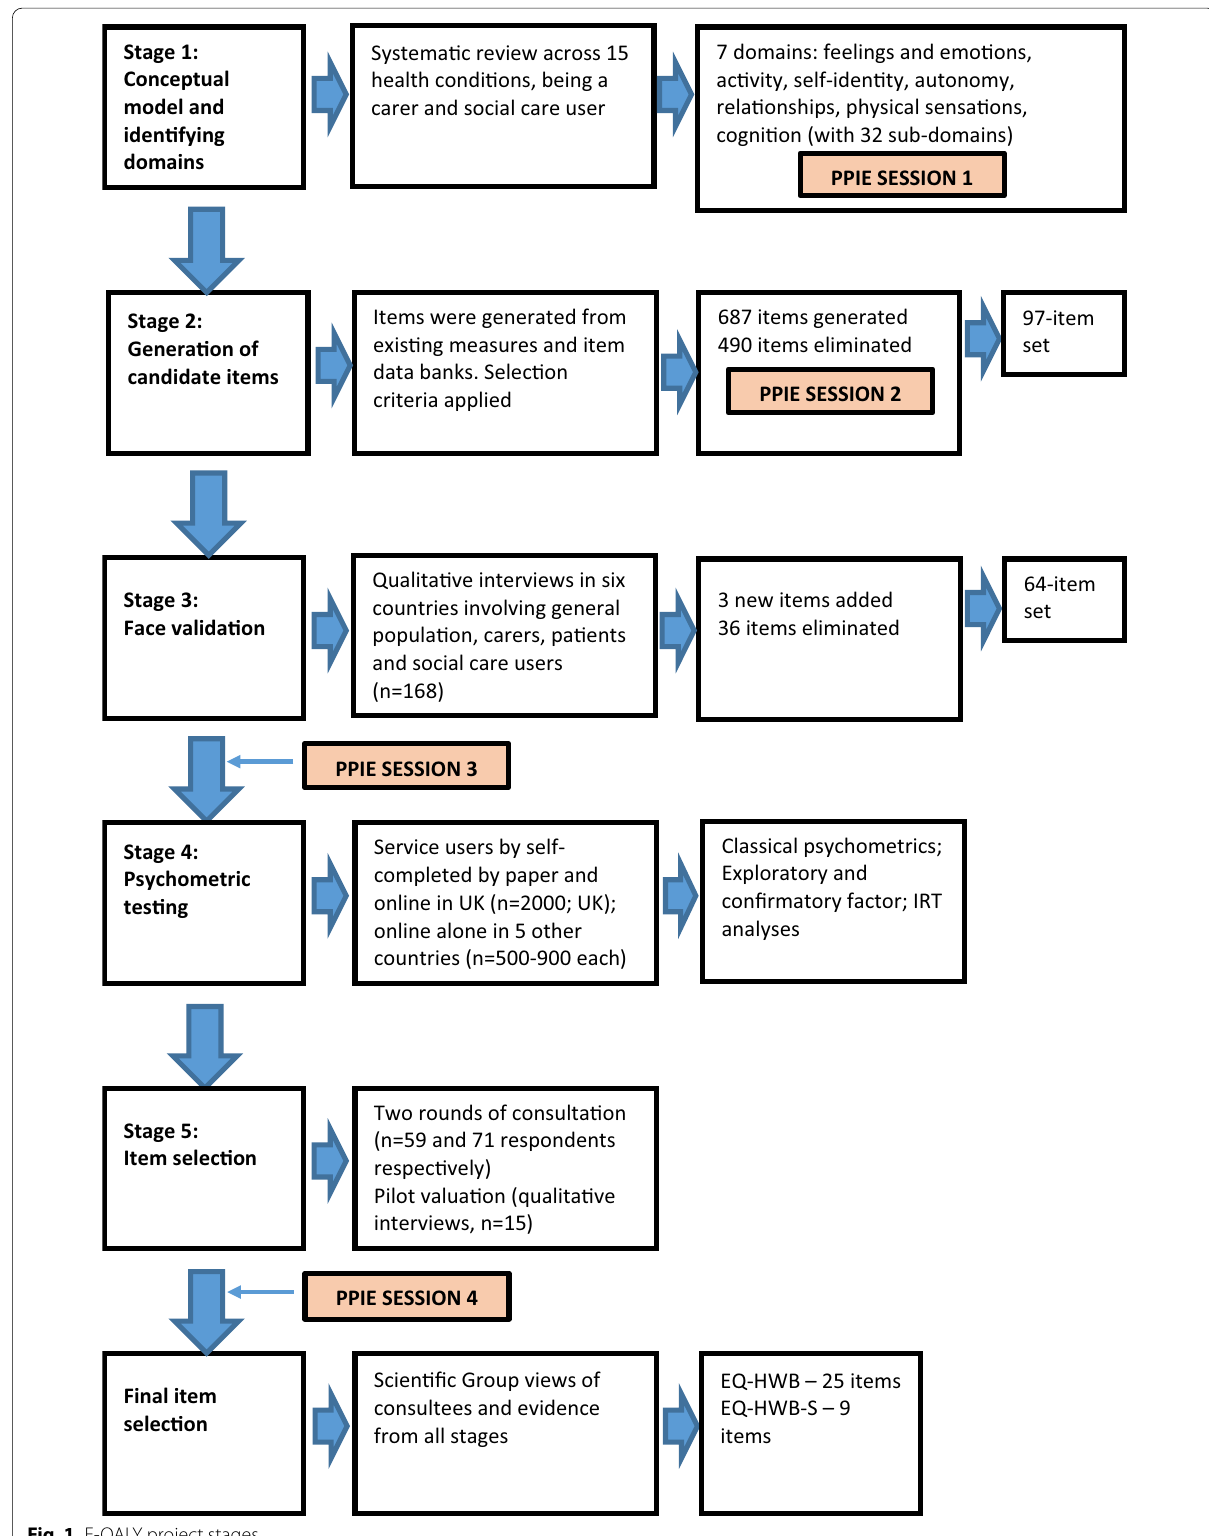
Fig. 1 E-QALY project